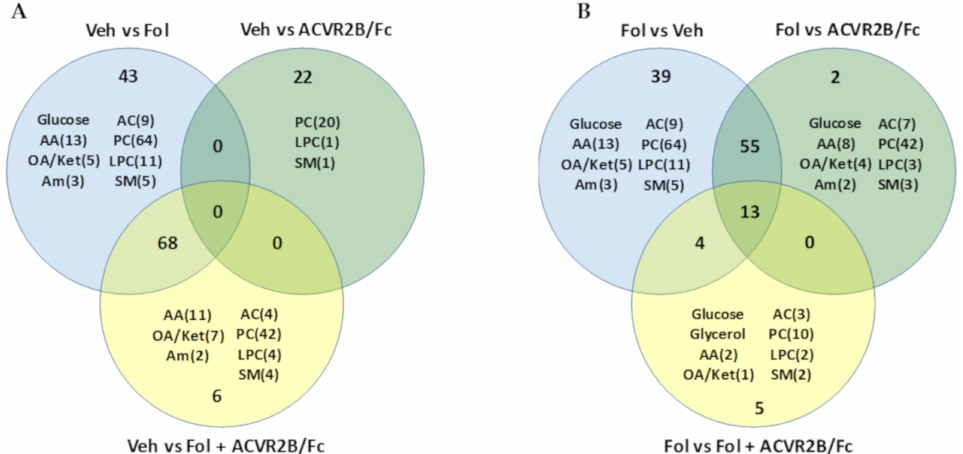
Figure 2. ( A ) Venn diagram of the di ff erences in the serum metabolome between the vehicle-treated group and the other three groups. Annotations inside each circle indicate the number of metabolites in di ff erent chemical classes that make up the di ff erences. ( B ) Venn diagram of the di ff erences between the Folfiri treated group and the other groups. AA, amino acids; OA / Ket, organic acids and ketones; Am, amines; AC, acylcarnitines; PC, glycerophosphcholines, LPC, lysophosphocholines; SM,